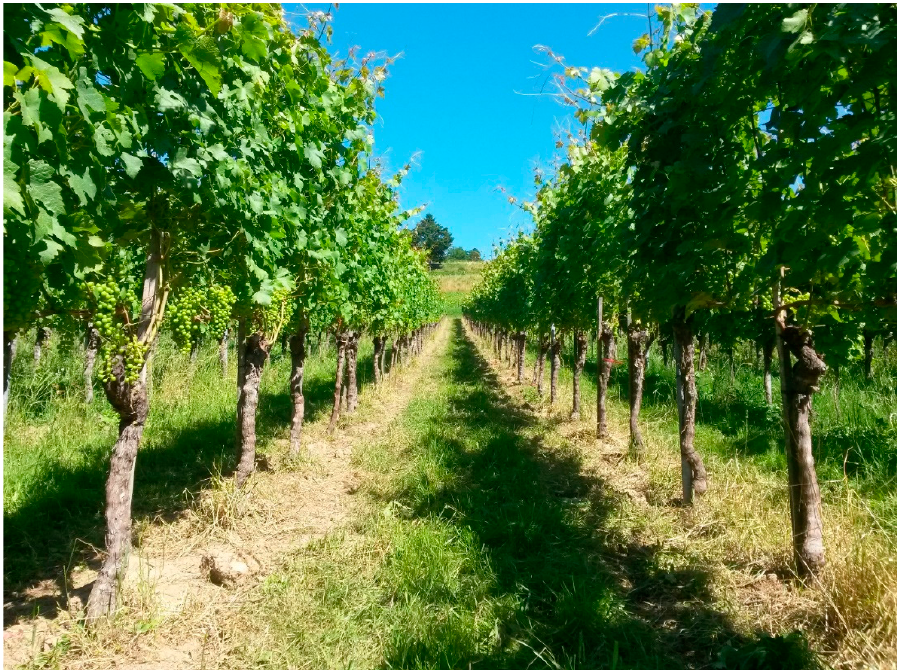
Figure 8. Effects after four days of grazing on approximately 450 m 2 of vineyard with 20 Ouessant sheep. To be seen here: inter-row vegetation grazing incl. in-row weed management (here also due to scratching and lying down), almost complete and highly welcome removal of sucker shoots as well as nearly perfect grape zone clearance (leaf plucking). Ideally, animals should change surfaces when the desired effect is achieved. Animals could possibly be forced by the lack of accompanying vegetation to make stronger efforts to reach higher vine leaves or to eat unripe grapes. Only those breeds whose wither heights are below the wire frame and any applied irrigation systems (so that these are passable) are likely to be suitable for short-term growing season deployment. If grazing is to be carried out over a longer period of time (several weeks) in Guyot systems, however, the majority of the evaluated breeds must either be discouraged or a relatively large number of adaptations to the vineyard must be